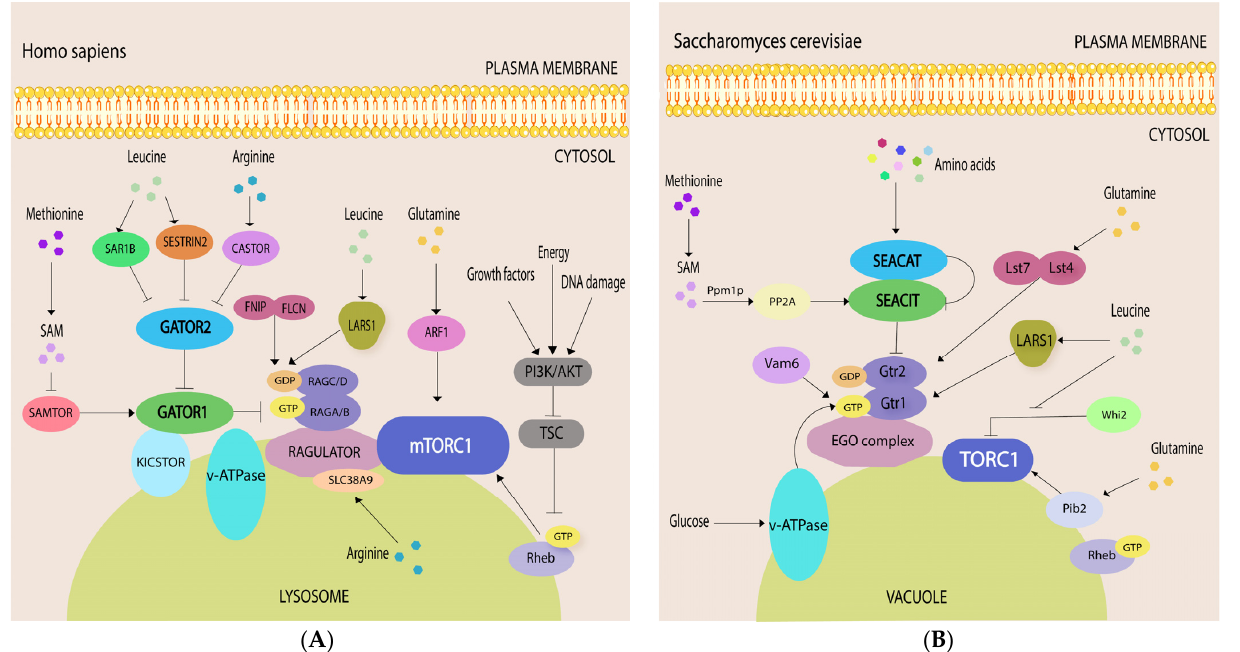
Figure 3. Amino acid signaling. ( A ) mTORC1 signaling in Homo sapiens . ( B ) TORC1 signaling in Saccharomyces cerevisiae . Yeast and mammalian orthologues are designated with the same color. Arrows and bars represent activation and inhibition, respectively. See text for more details.